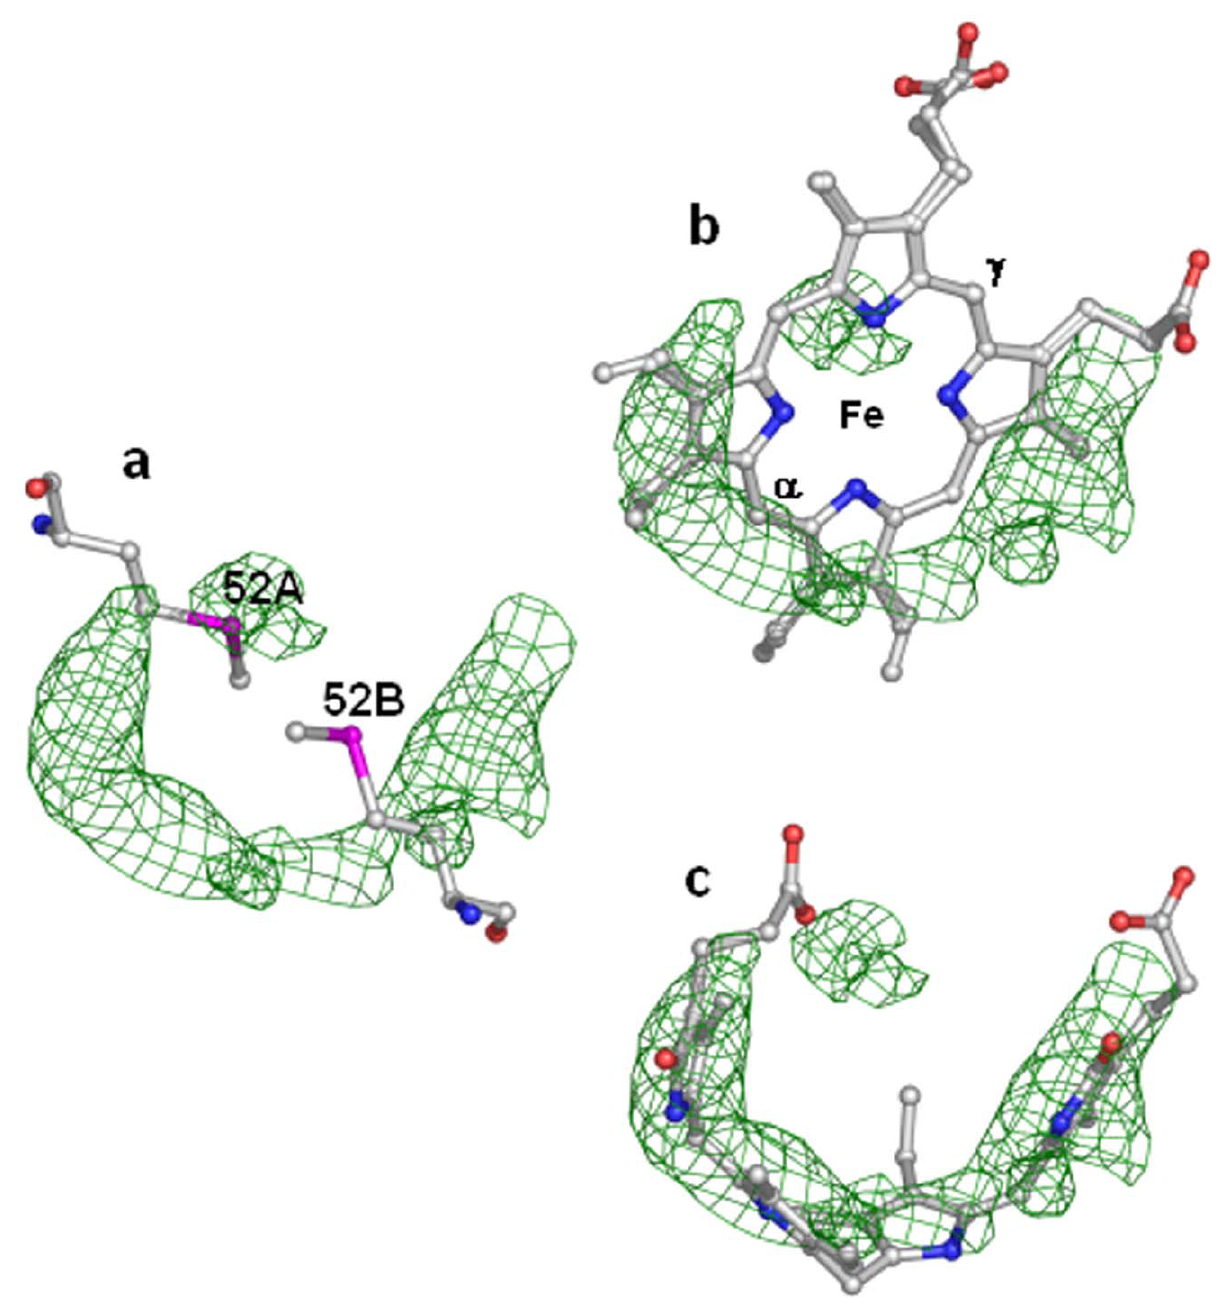
Figure 4. The F o 2 F c electron density map in the haem-binding region of Mtb SeMet-BfrA. ( a ) Sigma weighed F o 2 F c (green mesh contoured at 2.3 s ) map around the haem axial ligands SeMet52 from two subunits (shown as sticks in atom type colors) without any ligand build in it. ( b ) Superimposition of the haem coordinates from M. smegmatis Bfr (3bkn) on the F o 2 F c map demonstrates haem degradation at c position. The a and c methene bridges of the haem moiety are marked in the figure. ( c ) Similar superposition of the biliverdin IX- c (coordinates obtained from HIC- Up) illustrates partial fit to the density. Haem/biliverdin are modeled as sticks in atom type colors.